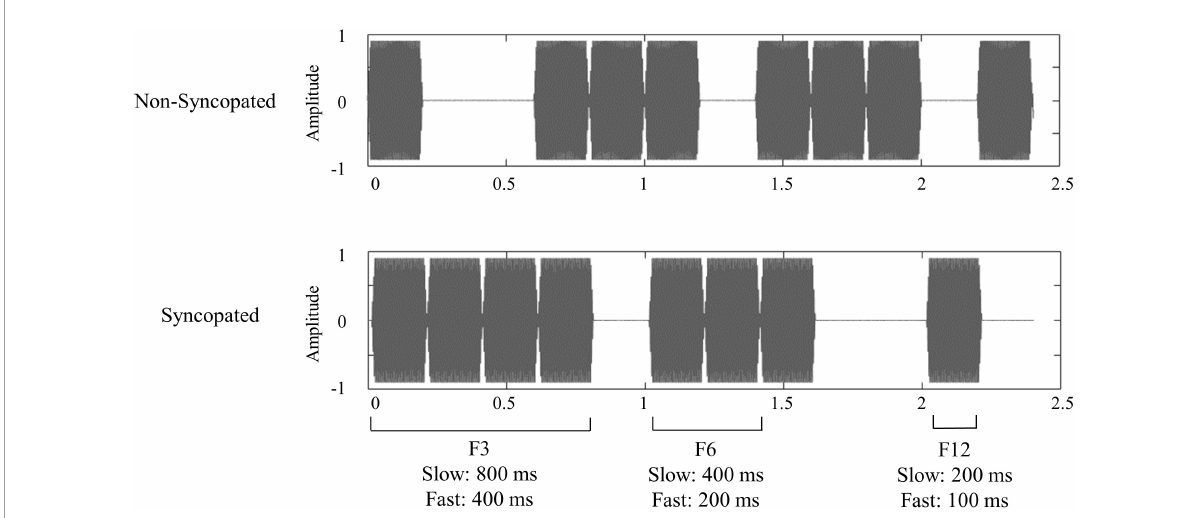
FIGURE1 Audio signal representation of the non-syncopated and syncopated rhythms at slow tempo (with 200 ms individual sounds).